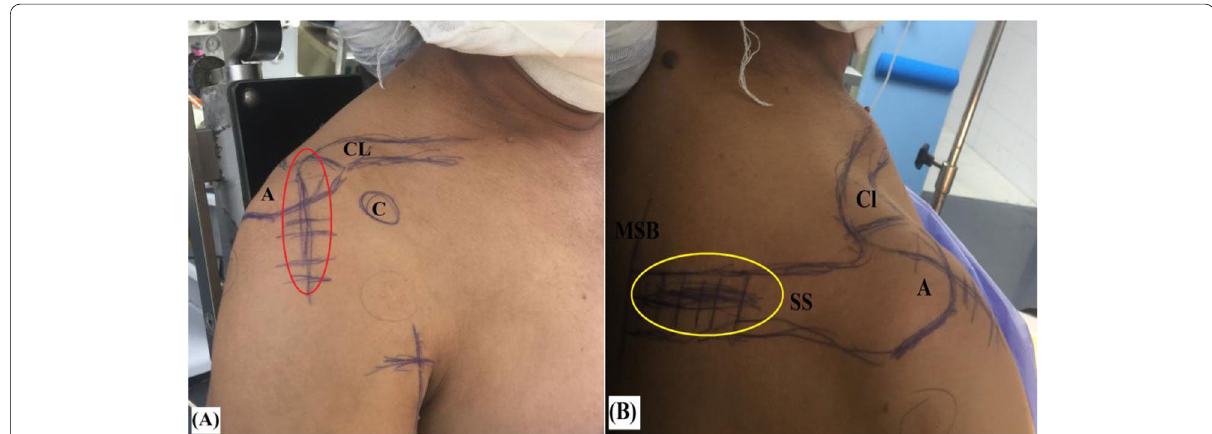
Fig. 2 A , B demonstrate pen‑marked soft‑tissue and bony anatomic landmarks, McKenzie approach (marked in red oval), and scapular spine approach (marked in yellow oval) of currently reported technique of middle trapezius tendon transfer in the right shoulder; A, anterior aspect of the shoulder. B, posterior aspect of the shoulder; A, acromion; C, coracoid process; Cl, clavicle (lateral end); MSB, medial scapular border; SS, scapular